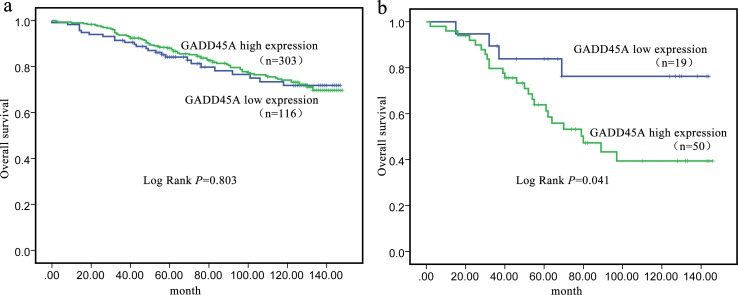
Kaplan–Meier curve of overall survival in relation to GADD45A protein expression.(A) breast cancer; (B) TN subtype breast cancer.